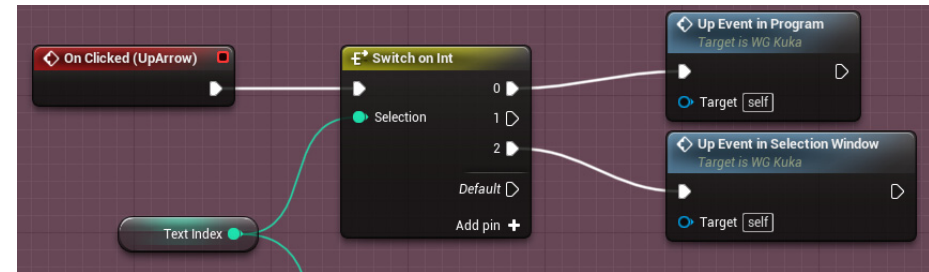
Figure 9. Blueprint of the On Clicked Up Arrow event.